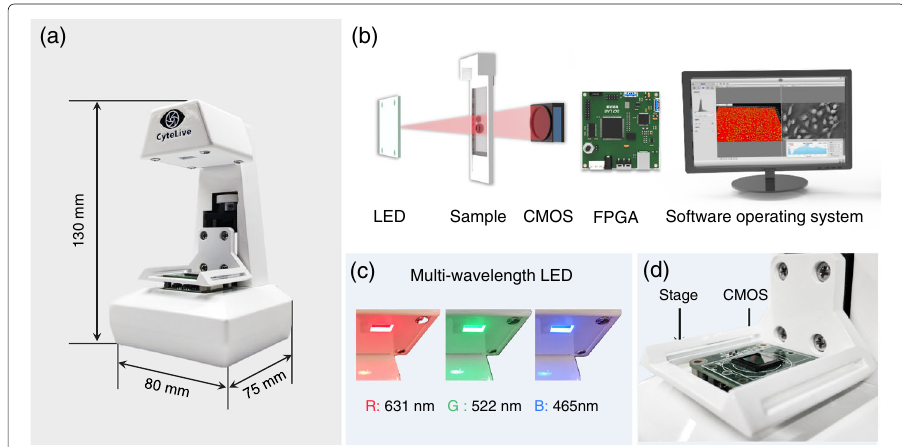
Fig. 26 Schematic diagram of HTL-SCLM system. (a) Physical diagram of HTL-SCLM system. (b) Hardware system interactive control diagram. (c) Multi-wavelength illuminations generated by a color LED unit. (d) Stage and CMOS